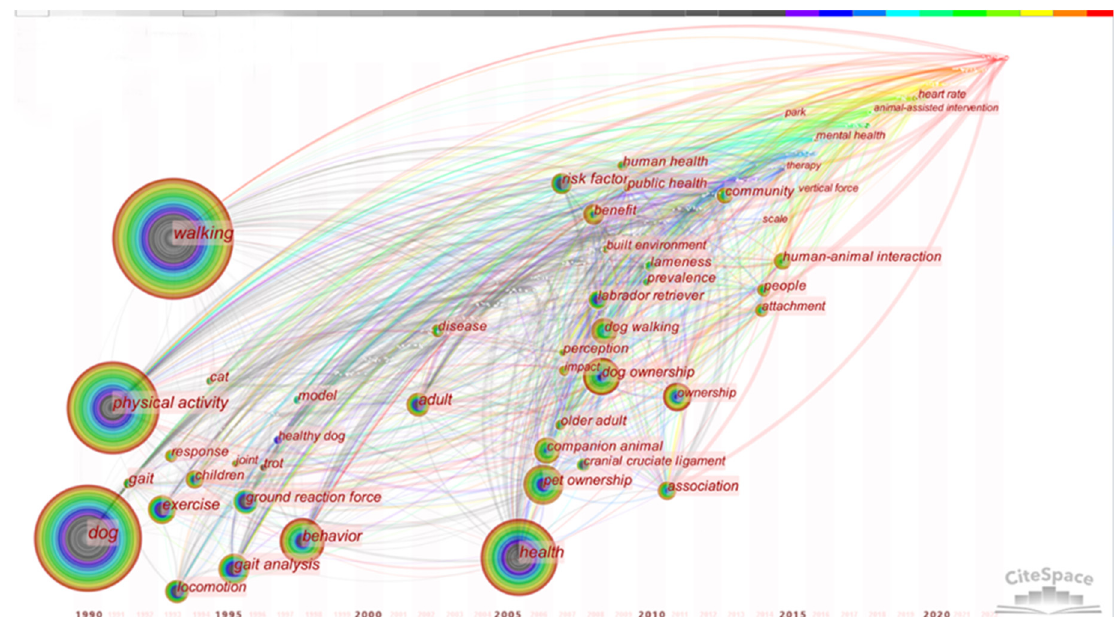
Figure 2. Time zone chart of keywords (each circle in the figure represents a keyword that first appears in the analyzed dataset and is fixed in the first year from the left side. If the keyword appears in a later year, it will be superimposed at the first occurrence).